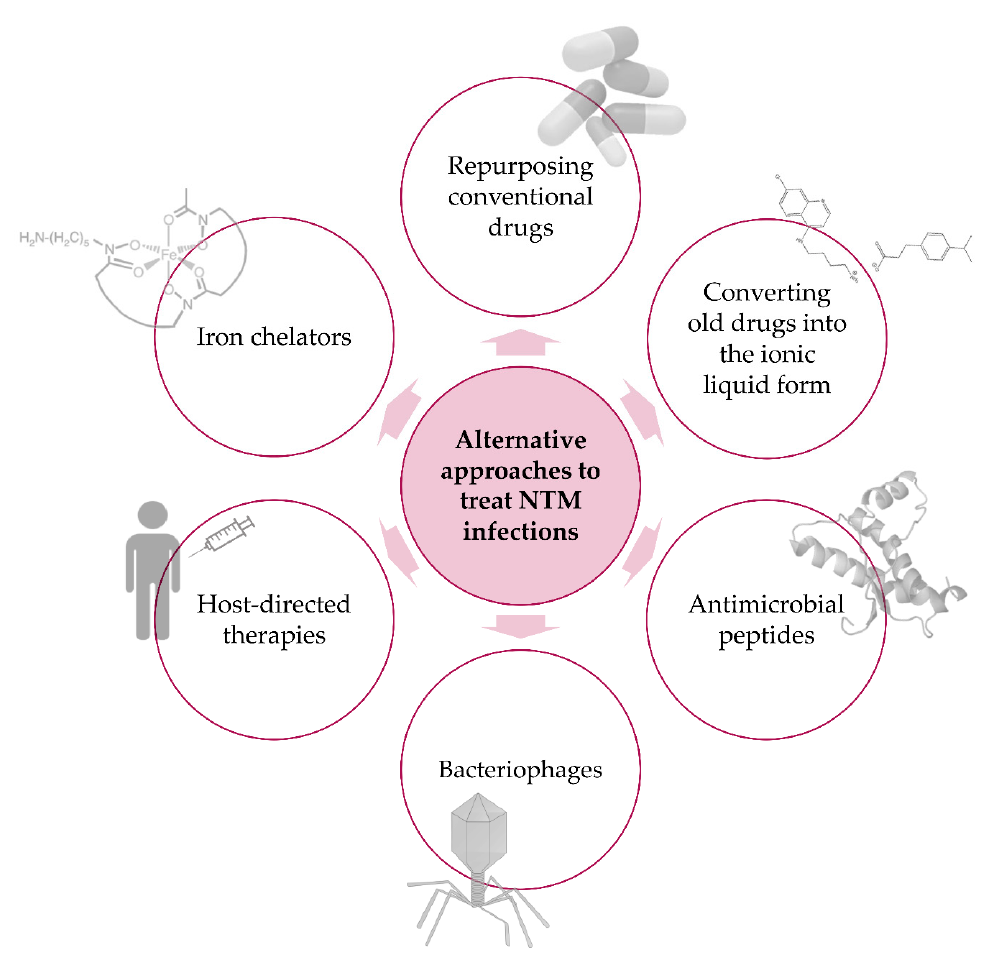
Figure 1. Alternative approaches to treat NTM infections. Schematic representation of new, promising alternatives to combat infectious diseases caused by NTM species.